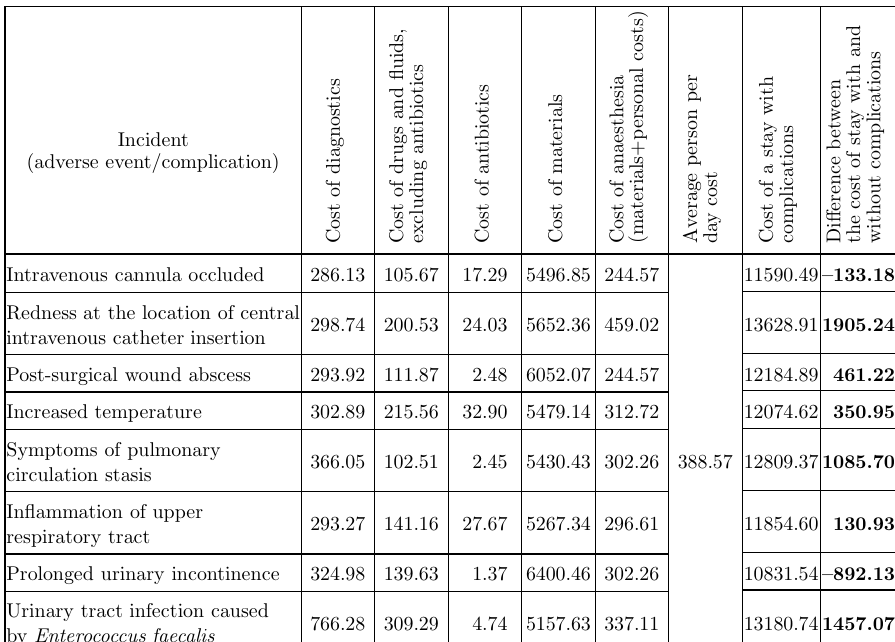
Table 4. Detailed analysis of H05 hospitalisation costs with